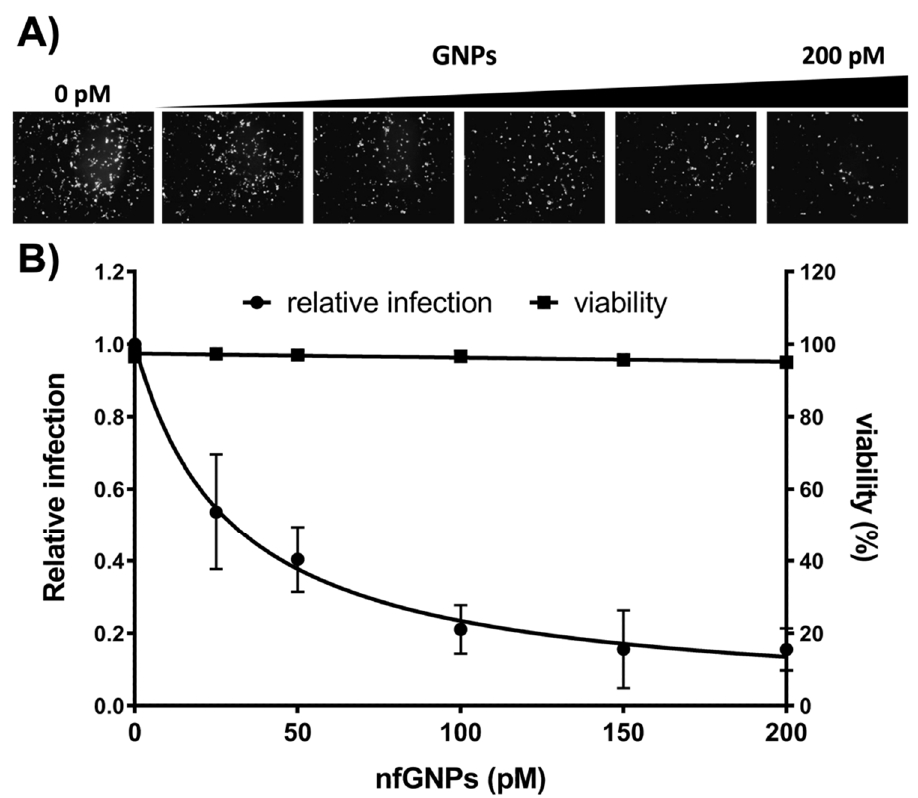
Figure 5. nfGNPs inhibit HPV16 PsV pseudo-infection. ( A ) Fluorescence microscopy of 293TT cells infected with PsV treated with nfGNPs. HPV16 PsV was incubated with increased concentrations of nfGNPs before 293TT cell infection. ( B ) Inhibition of PsV pseudo-infection by nfGNPs. Pseudo- infected 293TT cell fluorescence was quantified by flow cytometry and plotted relative to the non- treated PsV control. The graphs represent the mean and standard deviation of three independent experiments.